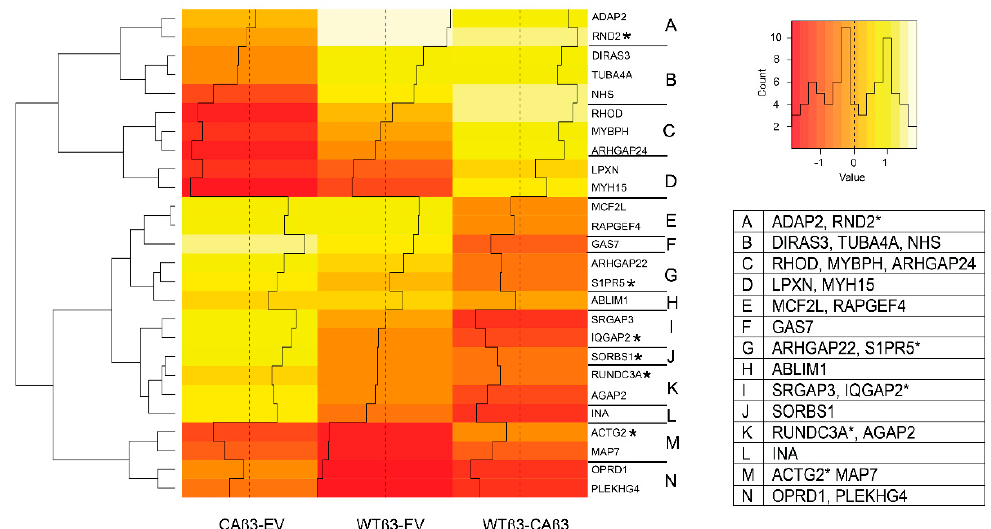
Figure 8. Hierarchical clustering of GTP-binding and cytoskeleton-associated genes finds differential gene expression in WT β 3 and CA β 3 cells relative to control EV cells and to each other. Genes from each of the three contrasts analyzed for DGE that met the Log 2 FC ± 1.5 cutoff and were classified as encoding GTP-binding and/or cytoskeleton-associated proteins were analyzed as in Figure 4. A heat map displaying standardized z-scores was generated. The clusters identified by letters on the right side of the map were determined manually. Genes within each of these clusters are listed in the displayed table. Those genes highlighted by an asterisk represent genes that had been dealt with as described for Figure 4.